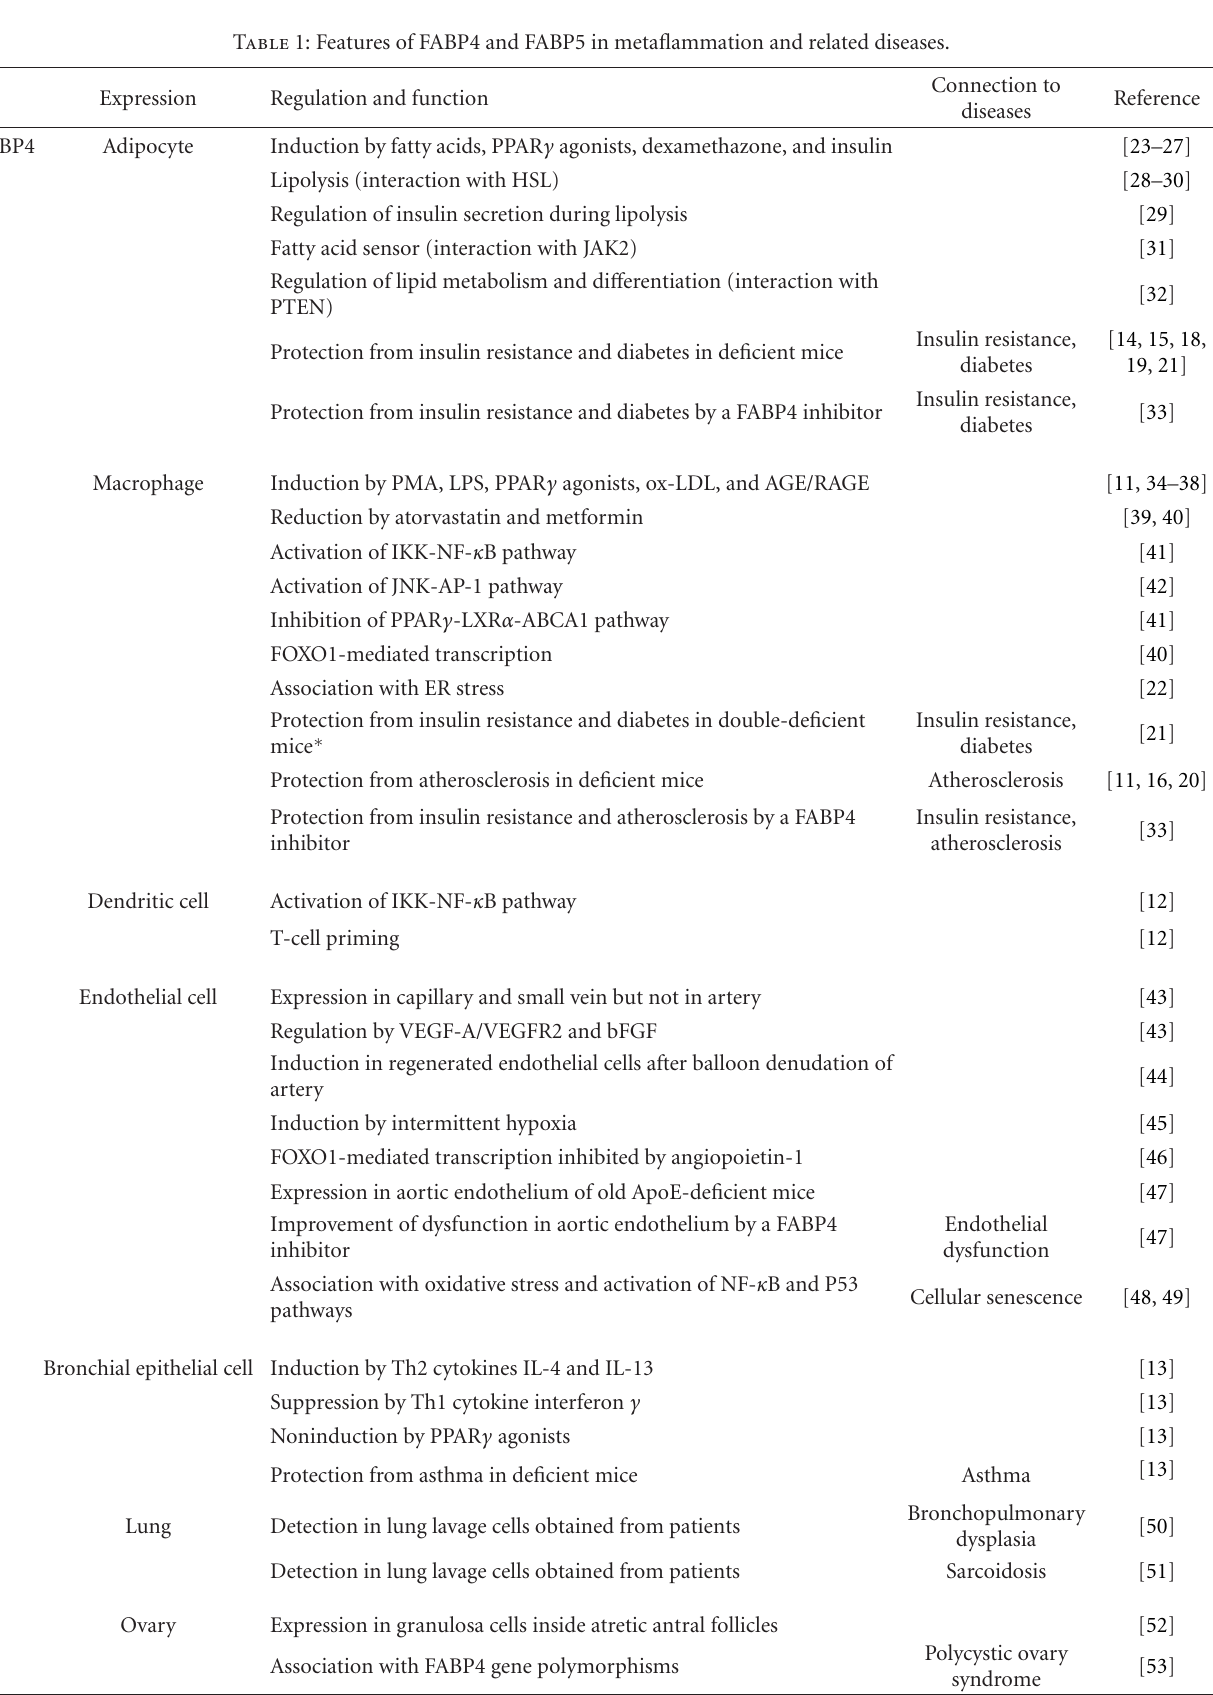
Table 1: Features of FABP4 and FABP5 in metaflammation and related diseases.